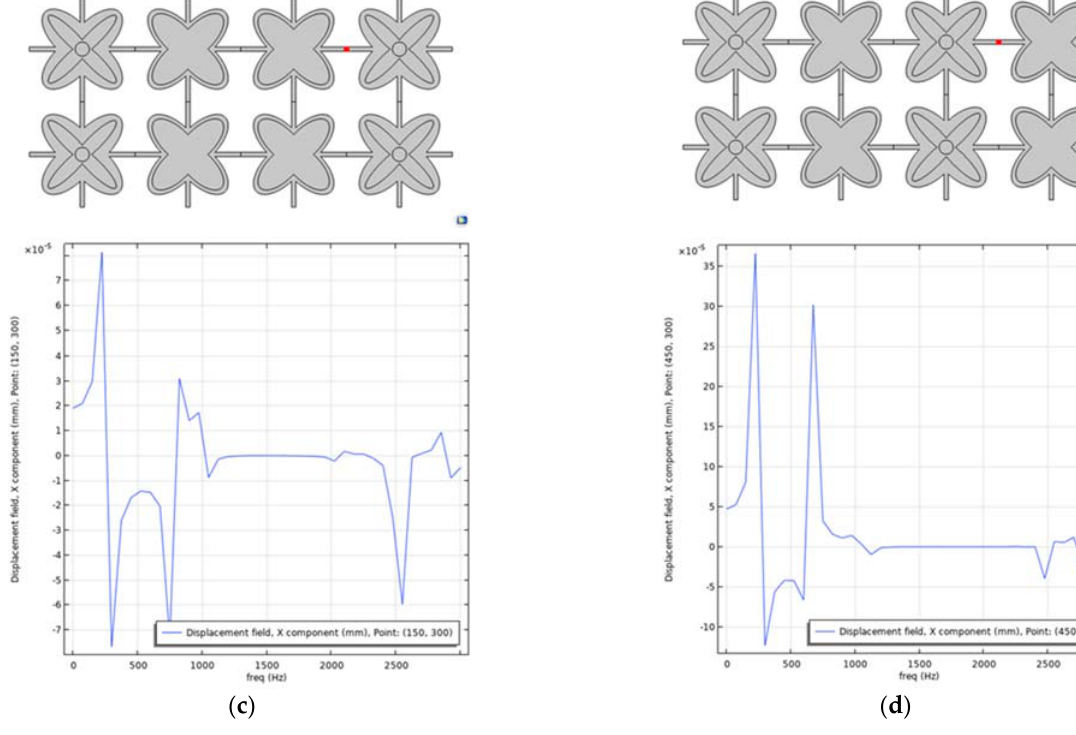
Figure 20. Different combinations of microstructures and the corresponding displacement-frequency diagrams. ( a ) first arrangement with two layers of complex microstructures in the middle rows, ( b ) two layers of complex microstructures at the end, ( c ) complex microstructures at first and last rows and ( d ) alternating placement of complex and simple